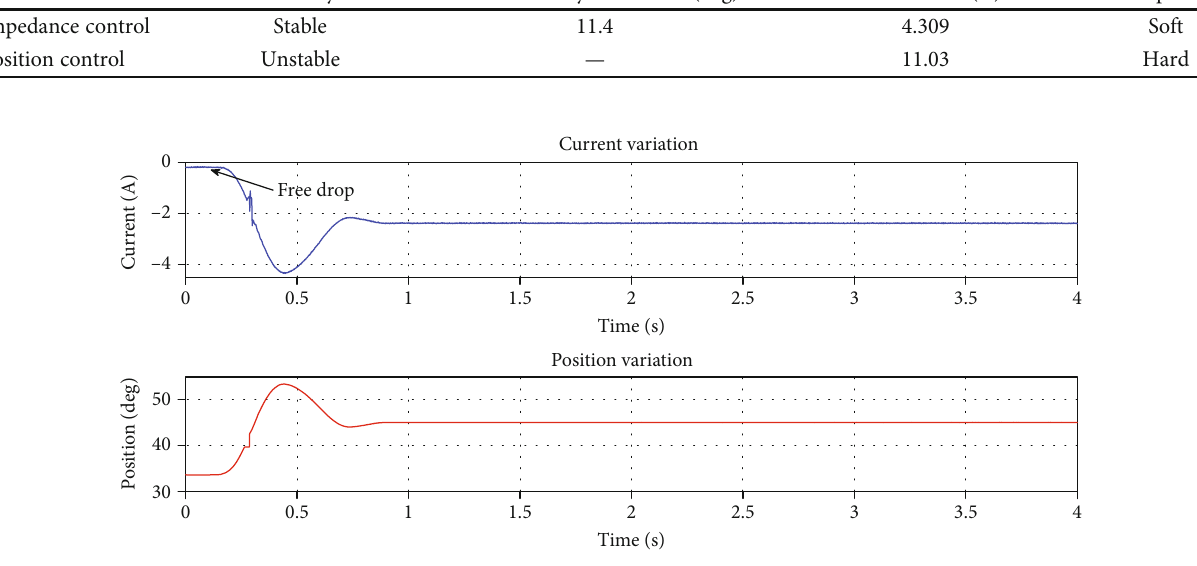
Figure 15: The current and position variation of the knee motor under impedance control.